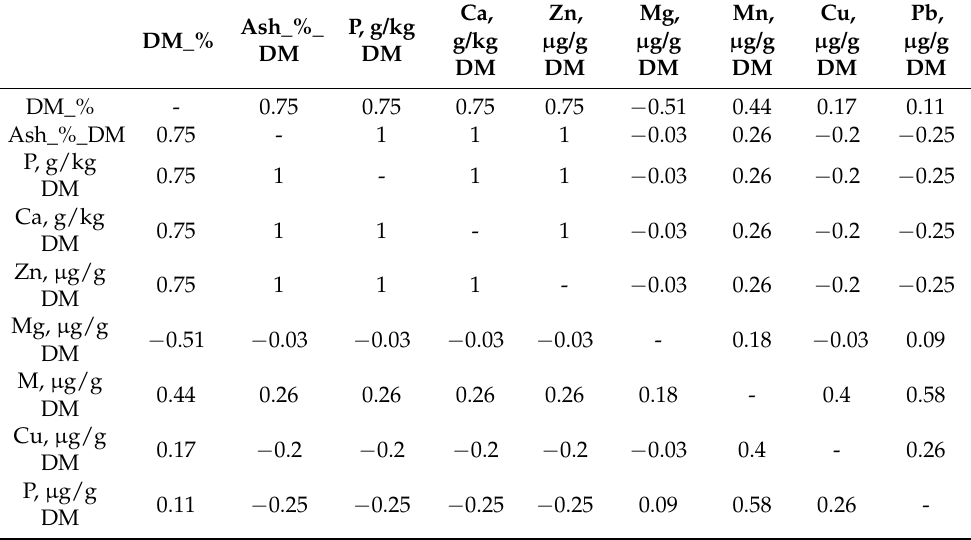
Table 2. Correlation coefficient (n = 7) (casewise deletion of missing data), marked values are significant at p ≤ 0.05.